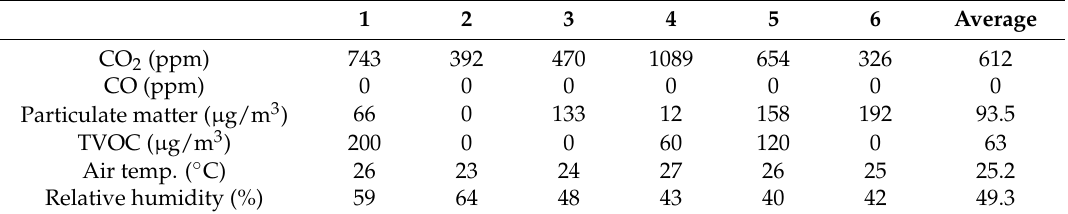
Table 6. CO 2 , CO, particulate matter, and TVOC concentrations, and found in university buildings in downtown Lisbon, Portugal, together with air temperature and relative humidity [19].